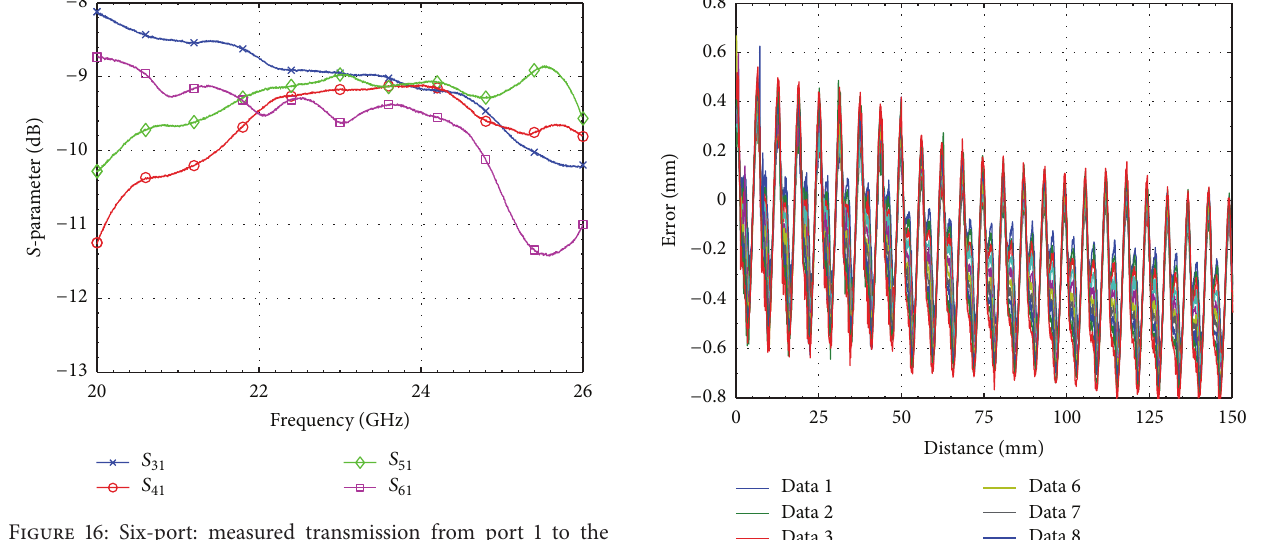
Figure 16: Six-port: measured transmission from port 1 to the output ports.